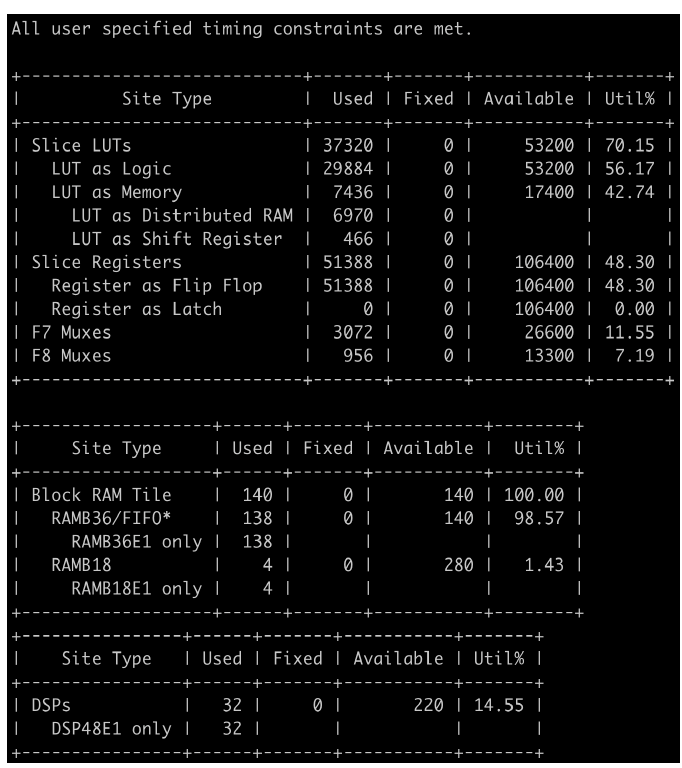
Figure 13. Hardware generation results. * Note: Each Block RAM Tile only has one FIFO logic available and therefore can accommodate only one FIFO36E2 or one FIFO18E2.